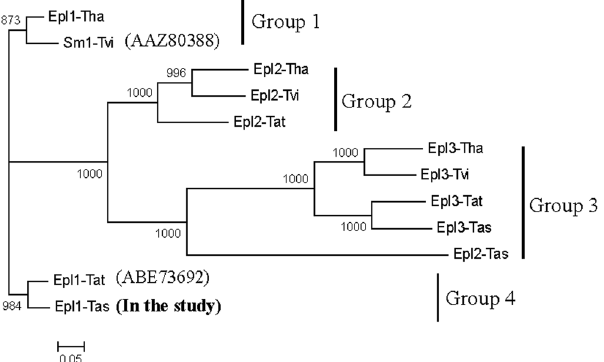
Figure 3. Phylogenetic tree of Epl1-Tas and its similar sequences. The bootstrap method was used to test the phylogeny with 1000 bootstrap replications. All branches showed significant support ( > 50% bootstrap values).